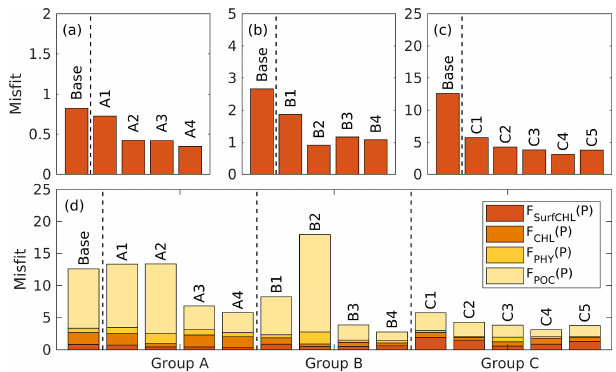
Figure 5. The case-specific cost function values (a–c) and total mis- fits (d) of the base case and the different